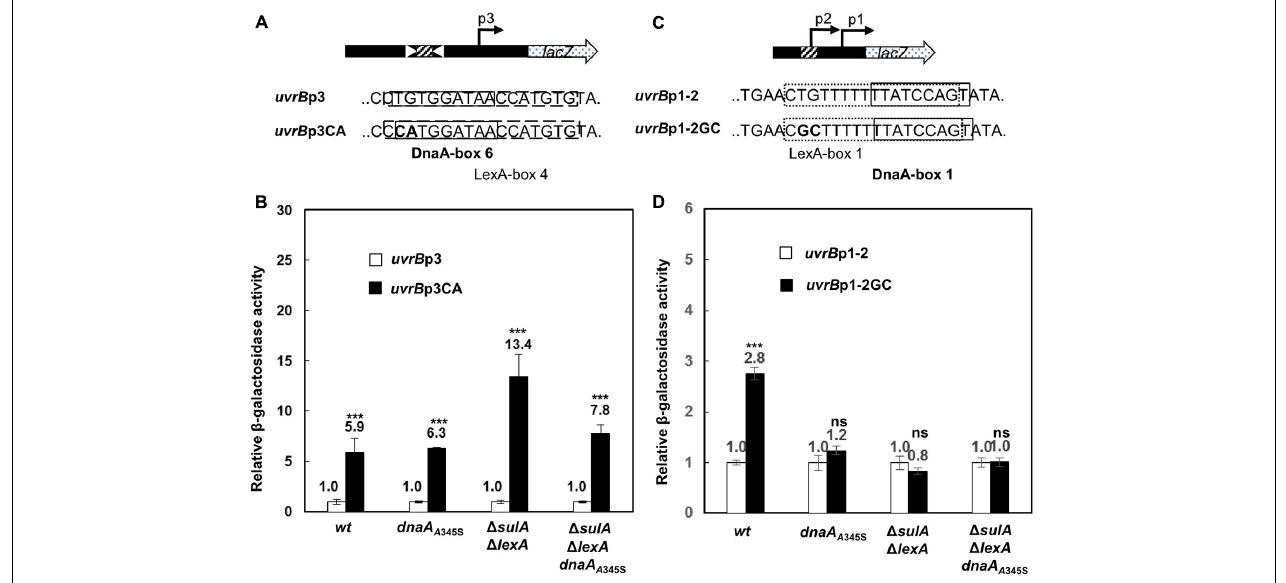
FIGURE 5 | DnaA-box6 in promoter uvrB p3 and LexA-box1 in uvrB p1-2 are important for control of the promoters. Mutations (TG to CA) in DnaA-box6 on plasmid uvrB p3 (A) and mutations (TG to GC) in LexA-box1 on plasmid uvrB p1-2 (C) were introduced, resulting in plasmid p uvrB p3CA- lacZ (indicated as uvrB p3CA for short) (A) and p uvrB p1-2GC- lacZ (as uvrB p1-2GC) (C) . The wild-type, dnaA A345S , (cid:49) sulA (cid:49) lexA and (cid:49) sulA (cid:49) lexA dnaA A345S cells were transformed with plasmid uvrB p3CA and uvrB p1-2GC, respectively. Relative activity of the mutated promoter uvrB p3CA (B) or uvrB p1-2GC (D) in the wild-type and the mutant cells was compared with that of uvrB p3 or uvrB p1-2 after measurement of the β -galactosidase activity as mentioned in the legend to Figure 2 . The open bars stand for uvrB p3 or uvrB p1-2, the filled bars for uvrB p3CA or uvrB p1-2GC. The values shown at top of the bars are the average of three individual experiments, and standard errors are shown. ∗∗∗ Stands for P -value ≤ 0.01, ∗∗ for 0.01 < P -value ≤ 0.05, and ns represents P -value > 0.05.